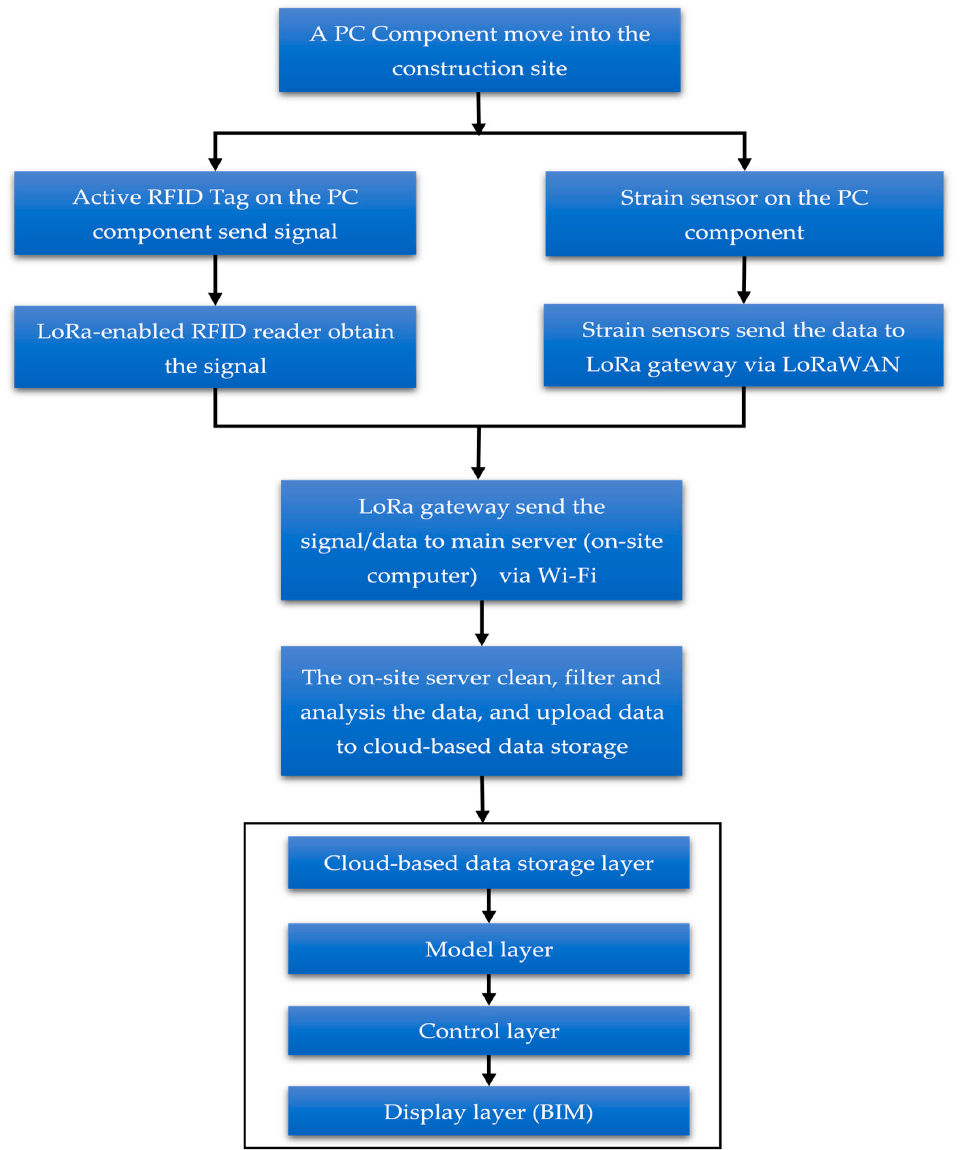
Figure 1. Flowchart illustrating the proposed method.